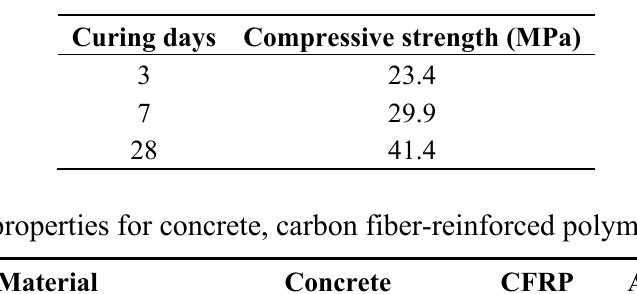
Table 2. The ultimate strength variation with curing days.